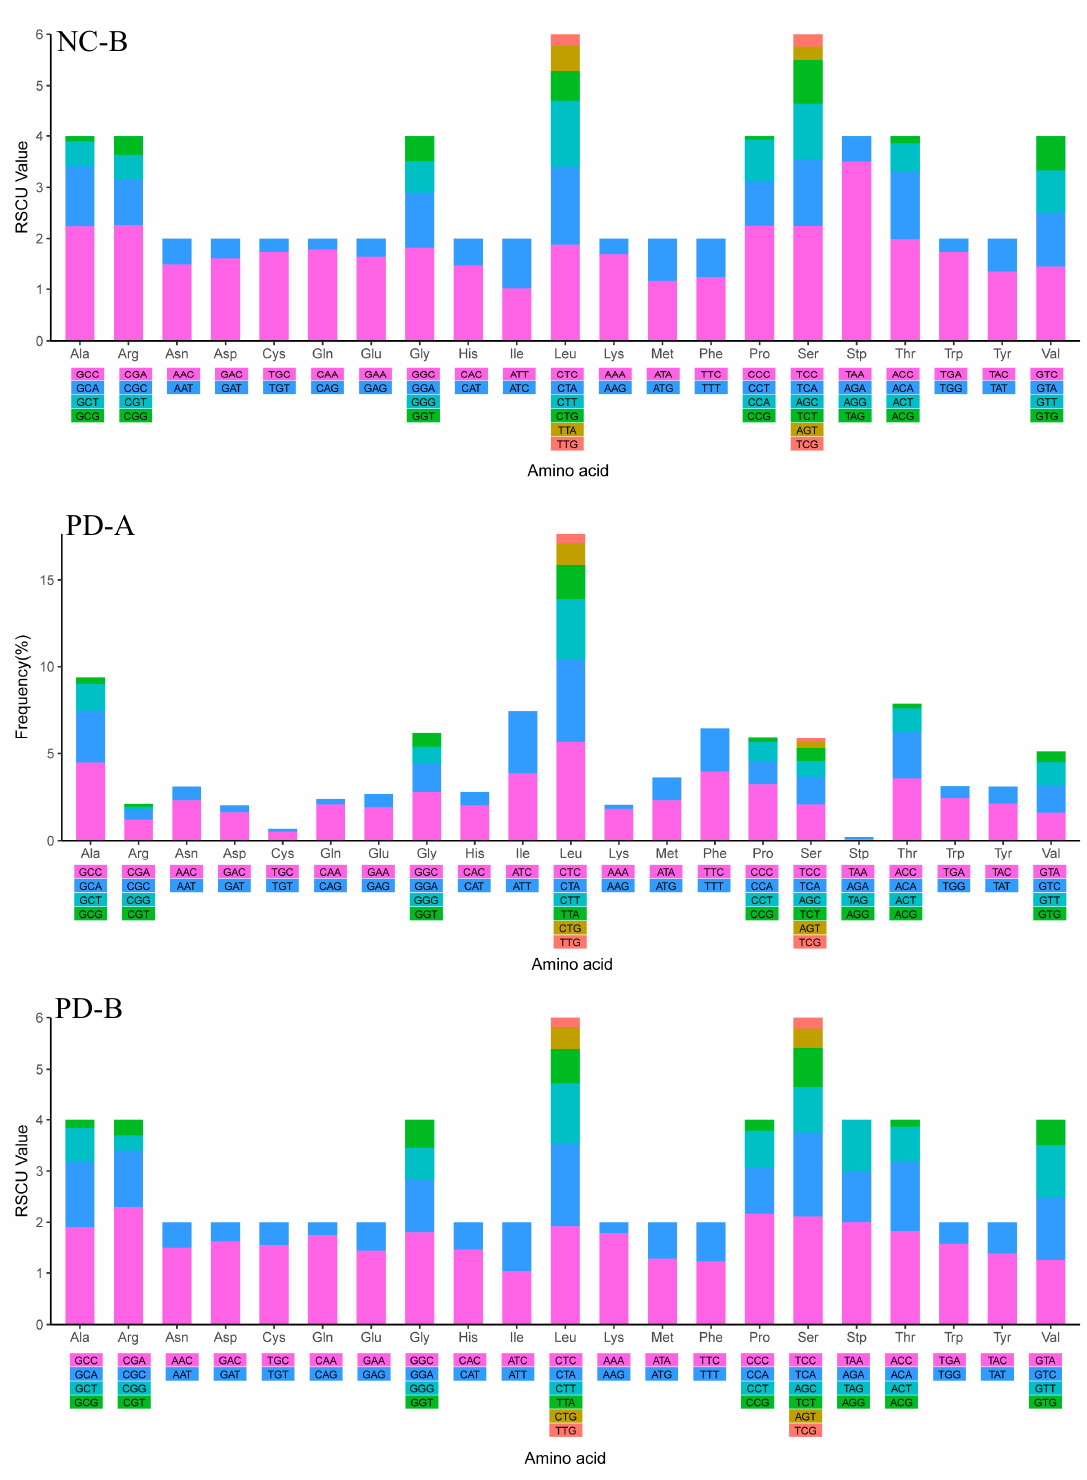
Figure 5. Codon Frequency ( A ) and RSCU (Relative Synonymous Codon Usage) ( B ) of mitochondrial genome for Argyrosomus amoyensis (AA), Nibea coibor (NC), and Protonibea diacanthus (PD).